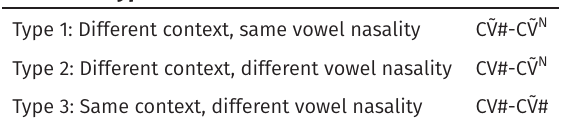
Table 3: Stimuli pairs divided by relevant